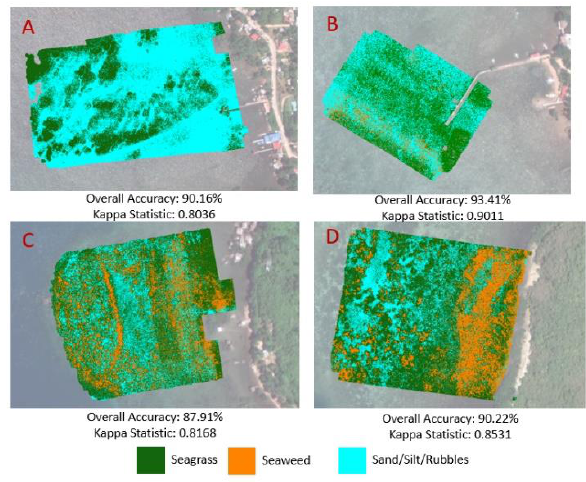
Figure 9. Results of the classification of UAV